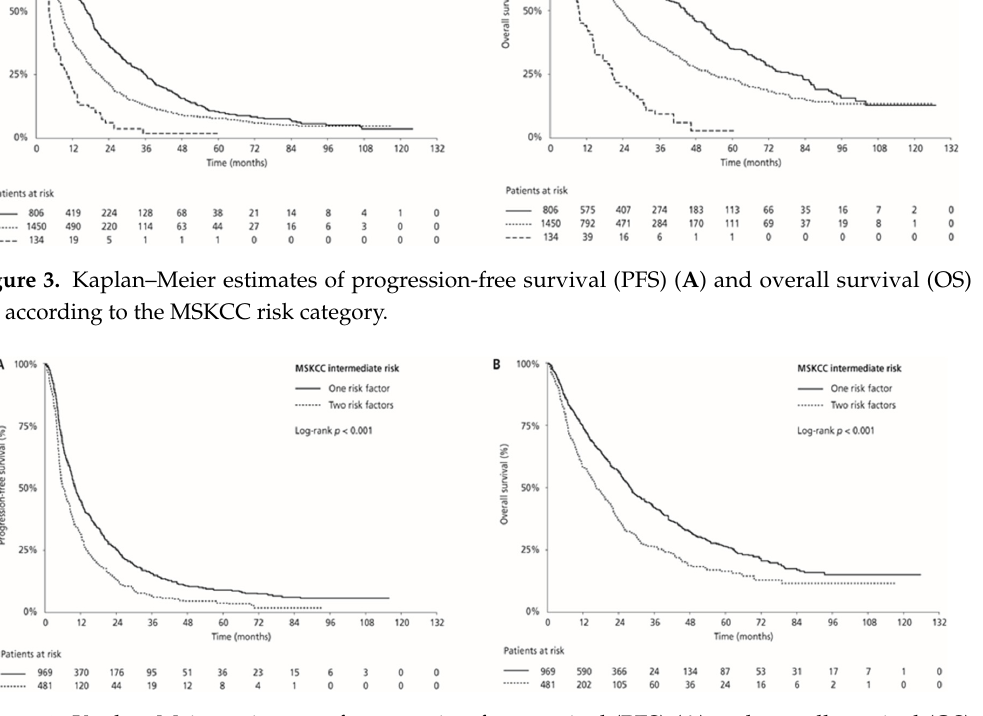
Figure 4. Kaplan–Meier estimates of progression-free survival (PFS) ( A ) and overall survival (OS) ( B ) 175 according to the number of risk factors in the MSKCC intermediate-risk group. 176